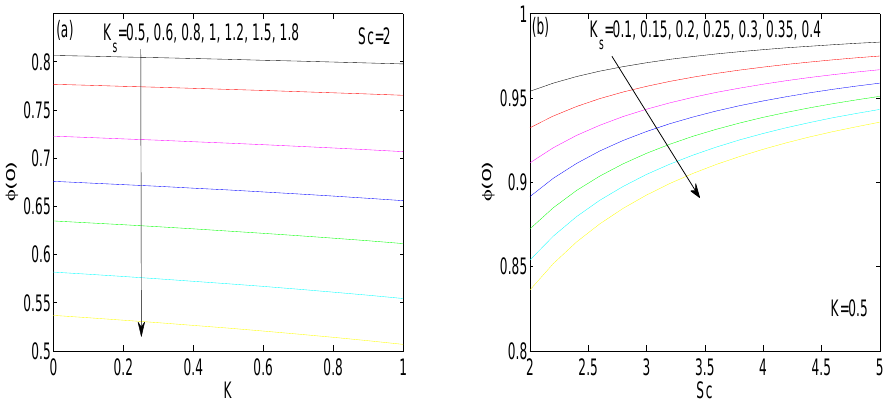
Figure 4. Graph of surface concentration ( φ ( 0 )) versus ( a ) K and ( b ) Sc at di ff erent values of heterogeneous reaction parameter K s . Table 1. Comparison of values of F (cid:4593) (0) and G (cid:4593) (0) obtained by Rahman and Andersson [12] for various suction-strength parameters.